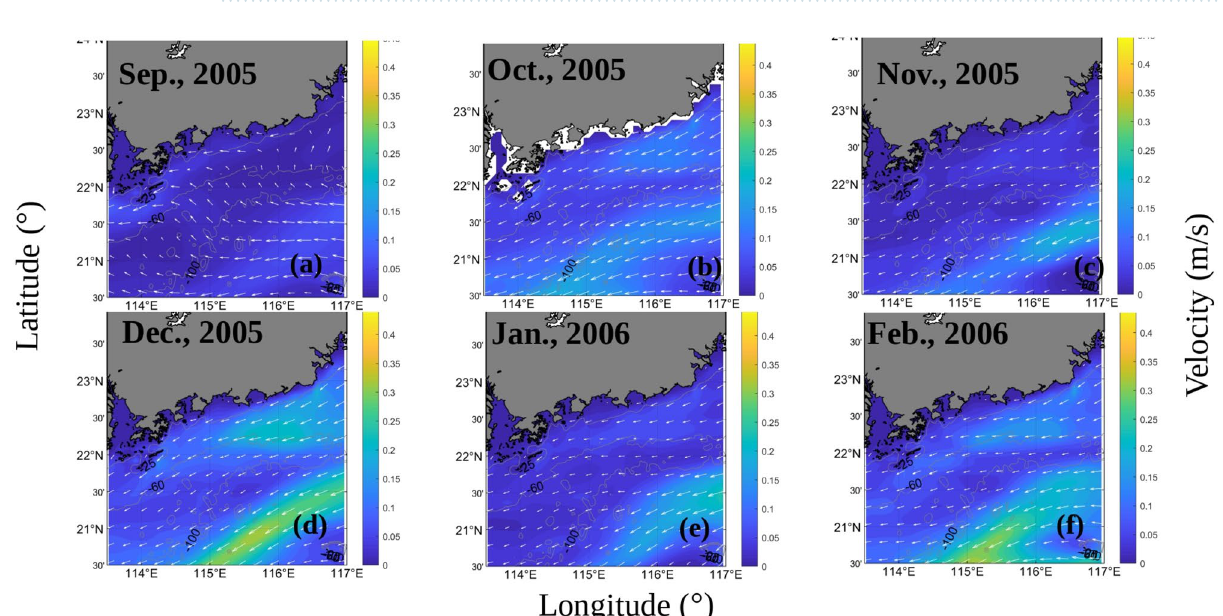
Figure 12. The monthly mean surface current velocities (m s −1 ) from September 2005 to February 2006. The program R (version 3.6.3, available at https:// www.r- proje ct. org) was applied for the